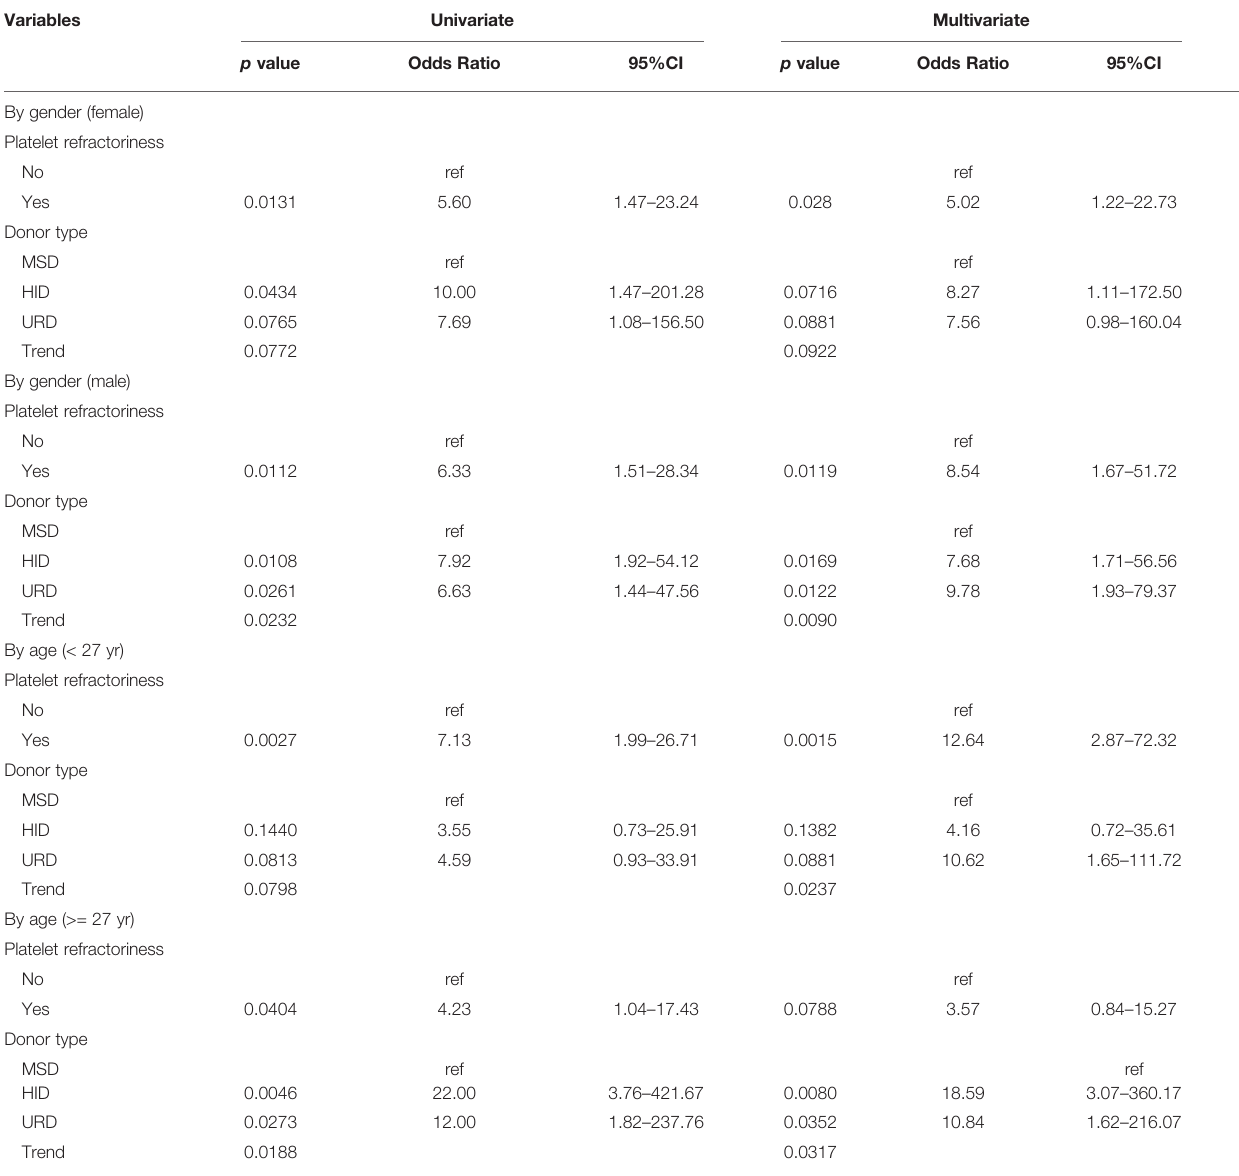
TABLE 5 | The association of pre-transplant factors with post-transplant CMVR risk was analyzed with strati fi cation by gender and age.